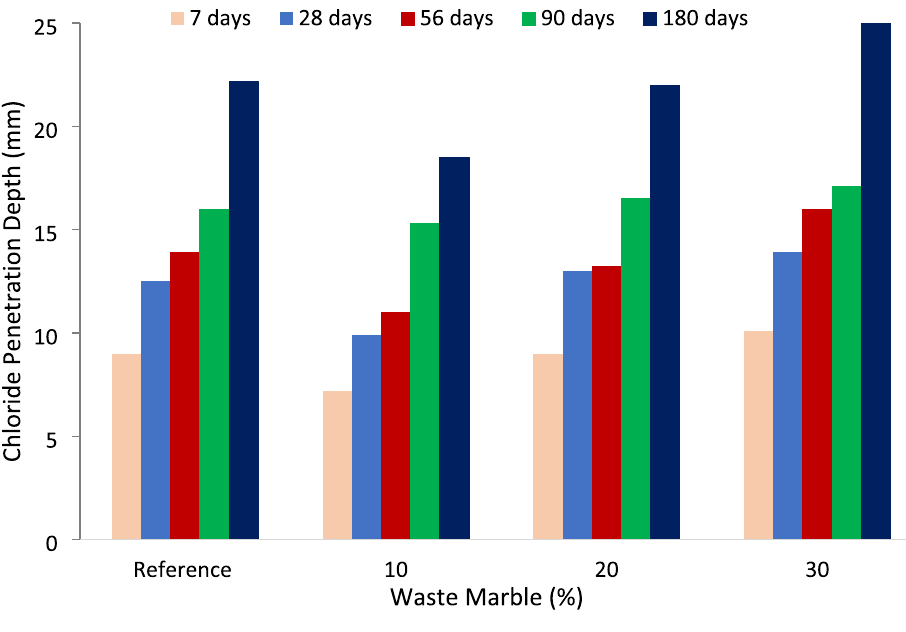
Fig. 15 Chloride ions penetration (Choudhary et al.,